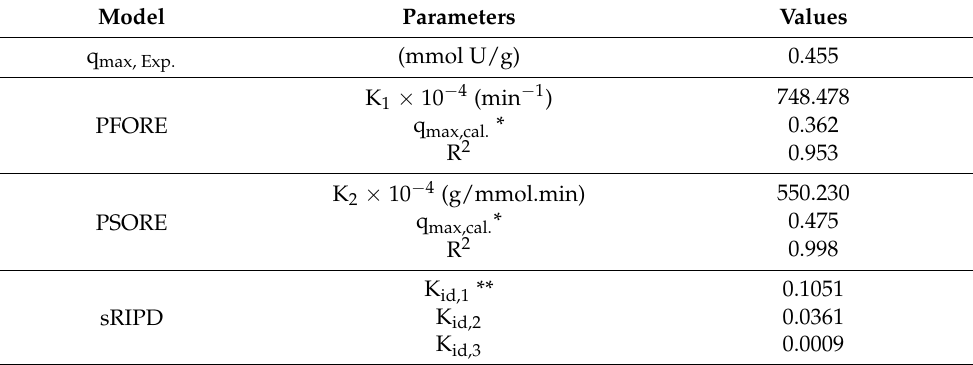
Table 2. Uptake kinetics for UO 22+ –parameters for the PFORE, PSORE, and sRIDE Model.